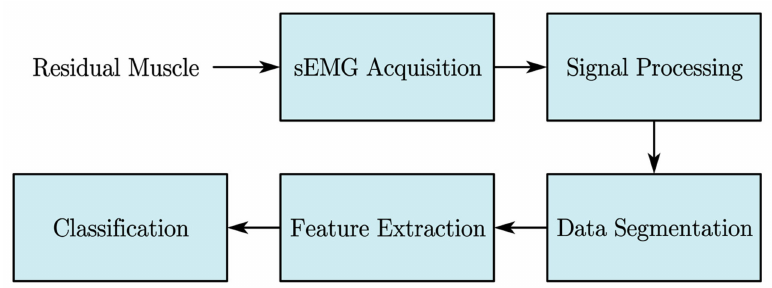
Figure 2. Typical top-level controller of an sEMG-based